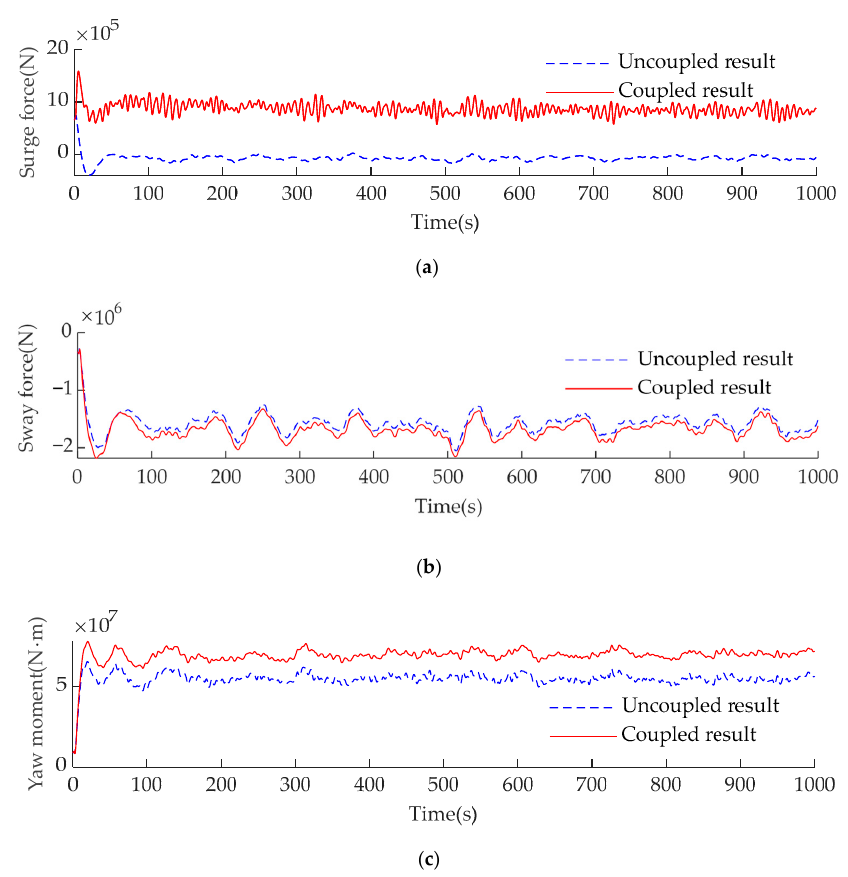
Figure 14. Dynamic total force thrust for uncoupled and coupled results: ( a ) Surge direction force; ( b ) Sway direction force; and ( c ) Yaw direction moment.